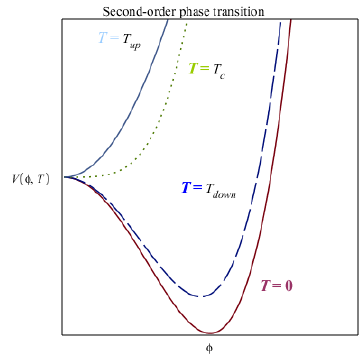
Figure 3 . New in(cid:13)ation model is presented by the second-order phase transition between two cases: T = T up and T = 0. In(cid:13)ation is mainly explained by T = 0 curve where at the (cid:12)rst step in(cid:13)aton rolls slowly down the nearly (cid:13)at part of the potential and in the second step near the minimum of the potential oscillates heating the universe. At the reheating epoch, thermal correction modi(cid:12)ed the potential as long-dashed blue curve T down which is in contrast with swampland